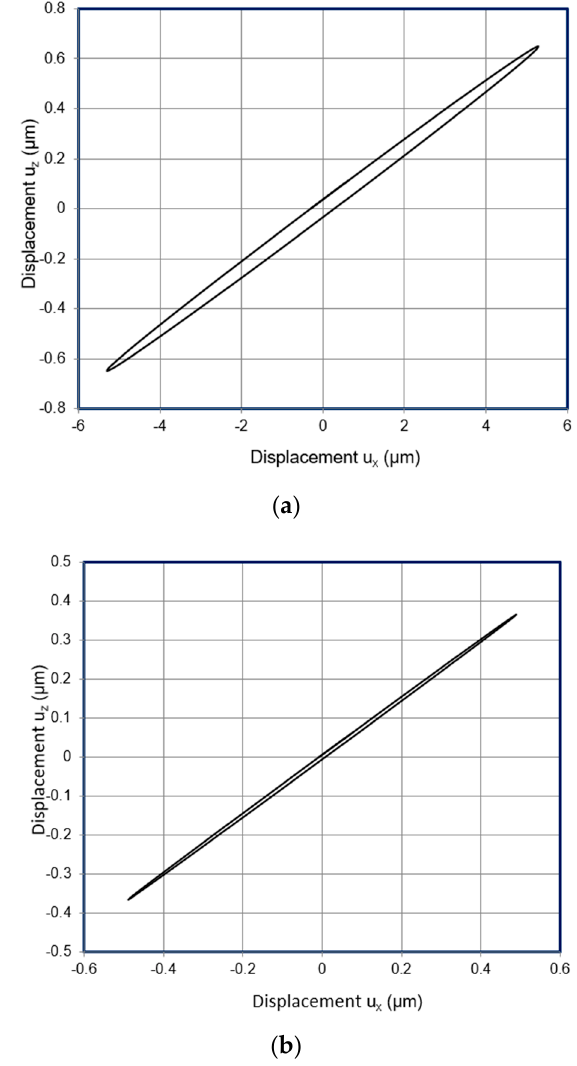
Table 3. Length of major and minor axes, μ m.